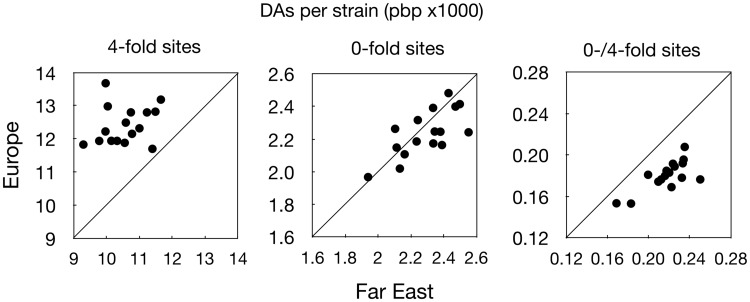
Divergence of European and Far East populations from their inferred common ancestor for 0- and 4-fold degenerate sites and the 0-/4-fold ratios (number of derived alleles [DAs] per strain, averaged across strains; points are for different chromosomes). Note ratios for Europe are below the 1:1 line, indicating stronger purifying selection in Europe.